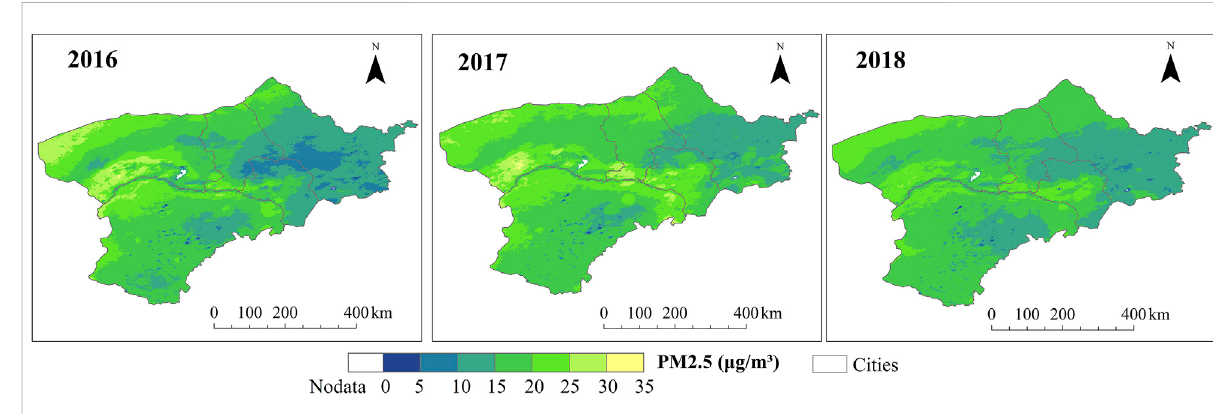
FIGURE 4 The spatial distribution of the average annual PM2.5 concentration in the study area from 2016 to 2018.